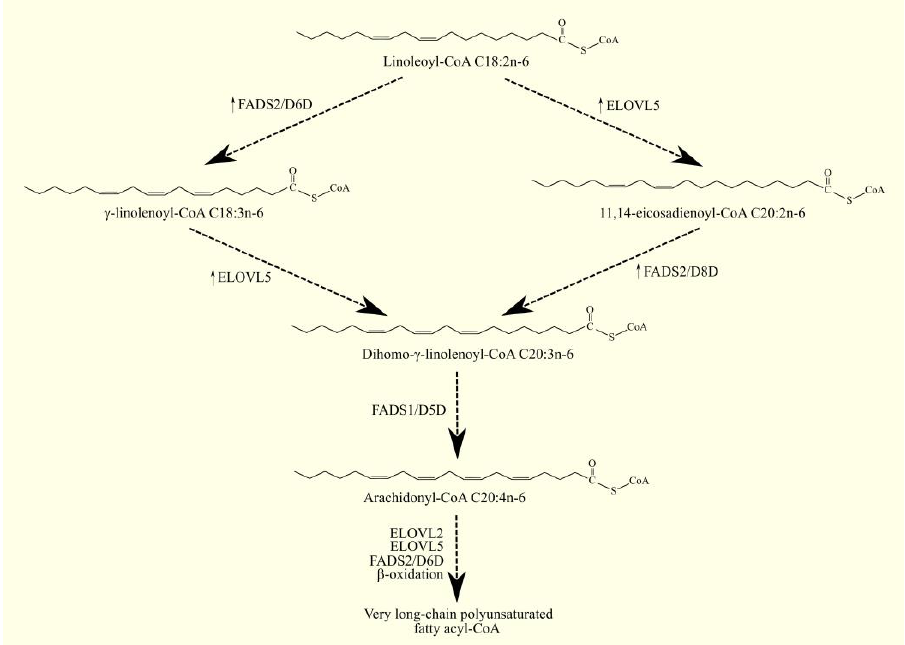
Figure 1. ARA biosynthesis. ARA C20:4n-6 in humans is not synthesized de novo but from linoleic acid C18:2n-6. As linoleoyl-CoA C18:2n-6, this PUFA undergoes desaturation to γ -linolenoyl-CoA